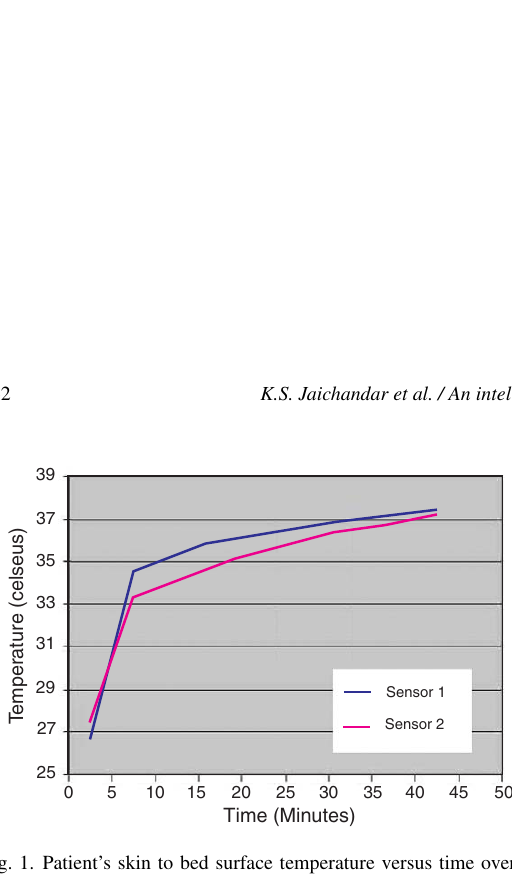
solutions for the bed sore problem. Observations indi-